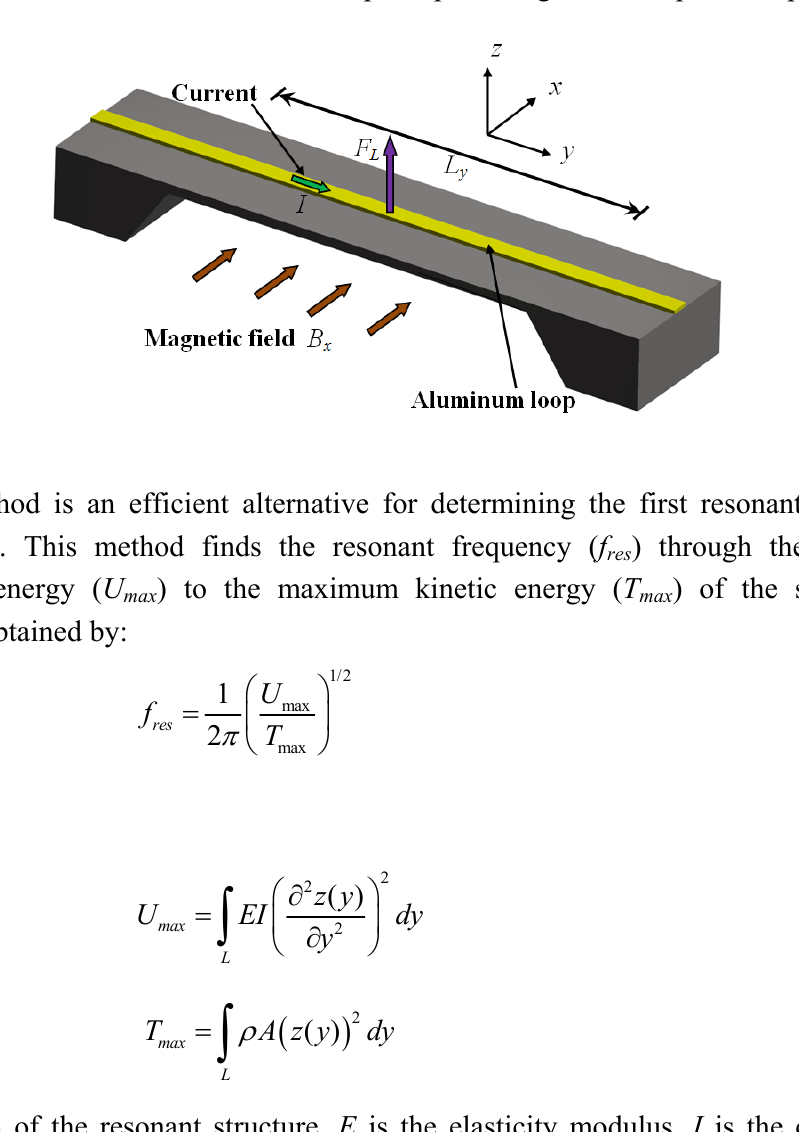
Figure 2. Schematic view of the Lorentz force principle acting on a clamped-clamped